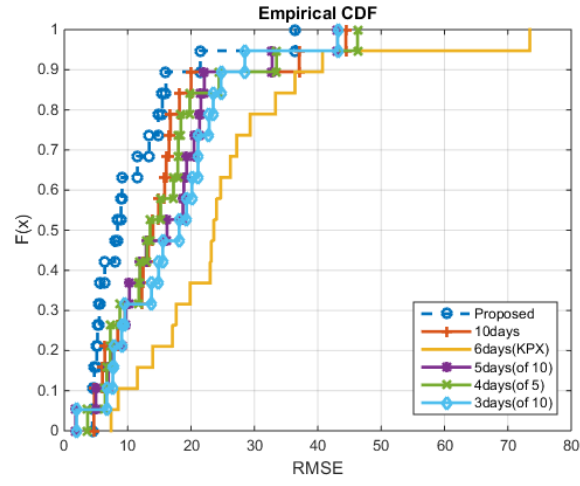
Figure 14. Cumulative distribution function (CDF) evaluation of the proposed models in site A.